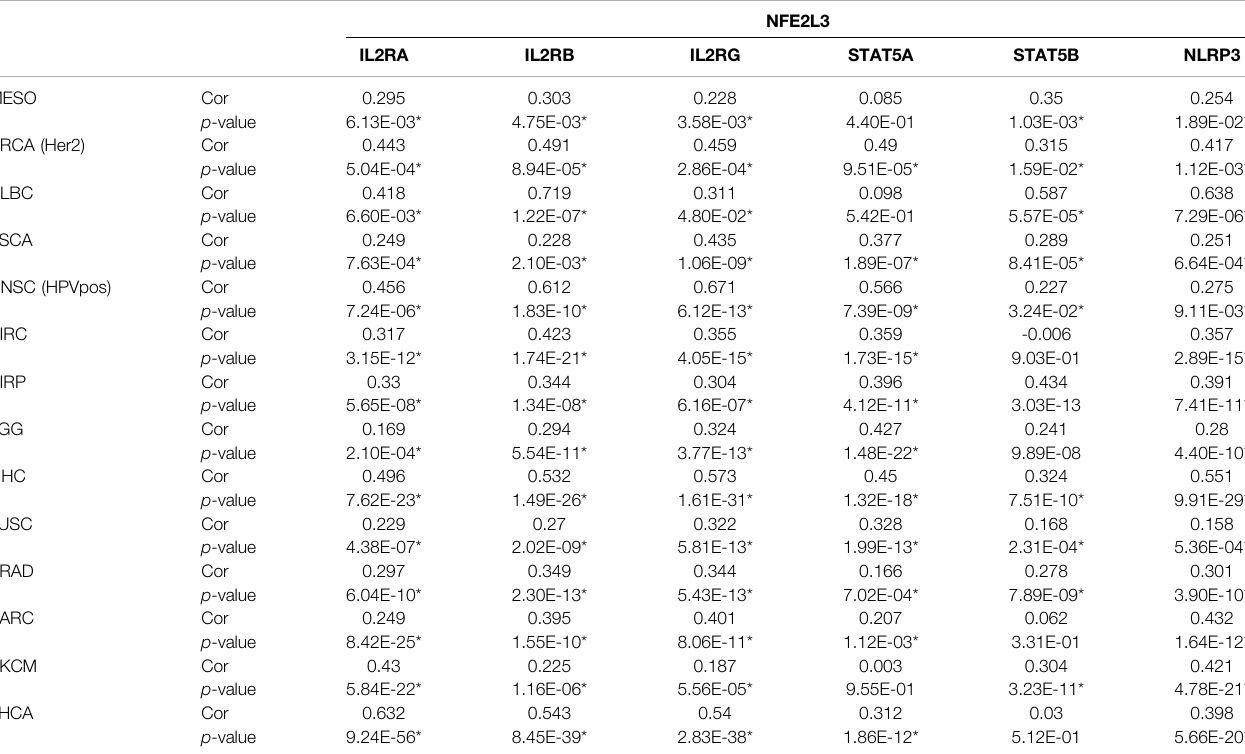
TABLE 2 | Correlation analyses between NFE2L3 and IL- 2R/STAT5/NLRP3 related genes in TIMER, which were adjusted by tumor purity. MESO, mesothelioma; BRCA (Her2), Her2 positive breast invasive carcinoma; DLBC, diffuse large B-cell lymphoma; ESCA, esophageal carcinoma; HNSC-HPVpos, HPV positive head and neck cancer; KIRC, kidney renal clear cell carcinoma; KIRP, kidney renal papillary cell carcinoma; LGG, low grade glioma; LIHC, liver hepatocellular carcinoma; LUSC, lung squamous cell carcinoma; PRAD, prostate adenocarcinoma; SARC, sarcoma; SKCM, skin cutaneous melanoma; THCA, thyroid carcinoma; Cor, R value of Spearman ’ s